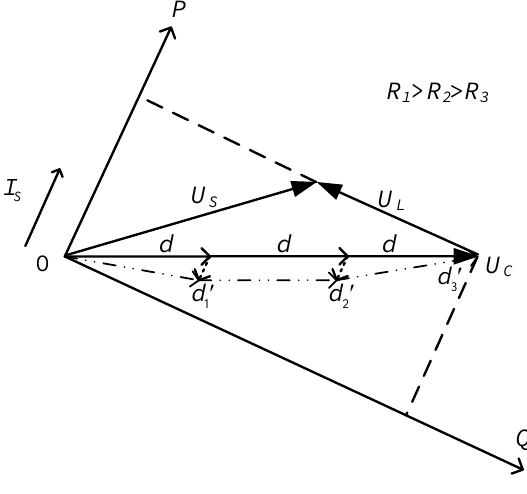
Figure 6. Duty cycle vector diagram.